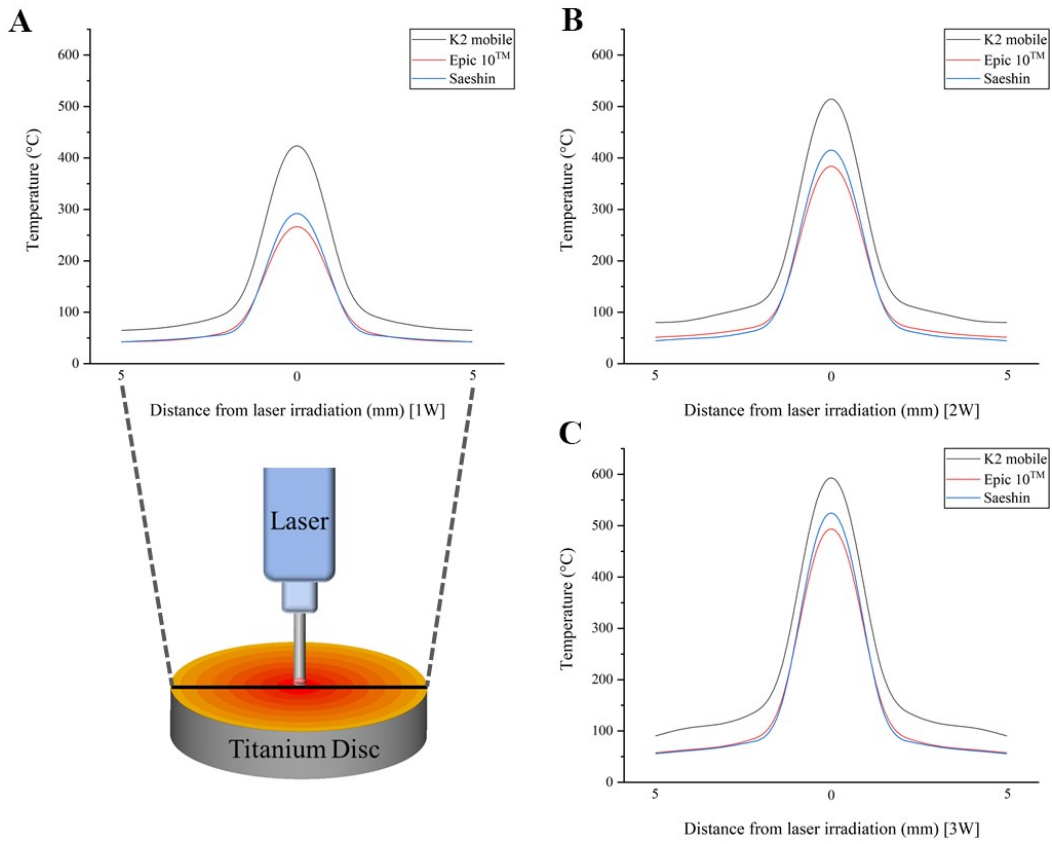
Figure 2. Comparison of temperature after laser irradiation using three types of dental diode lasers. ( A ) 1W, ( B ) 2W, ( C ) 3W.